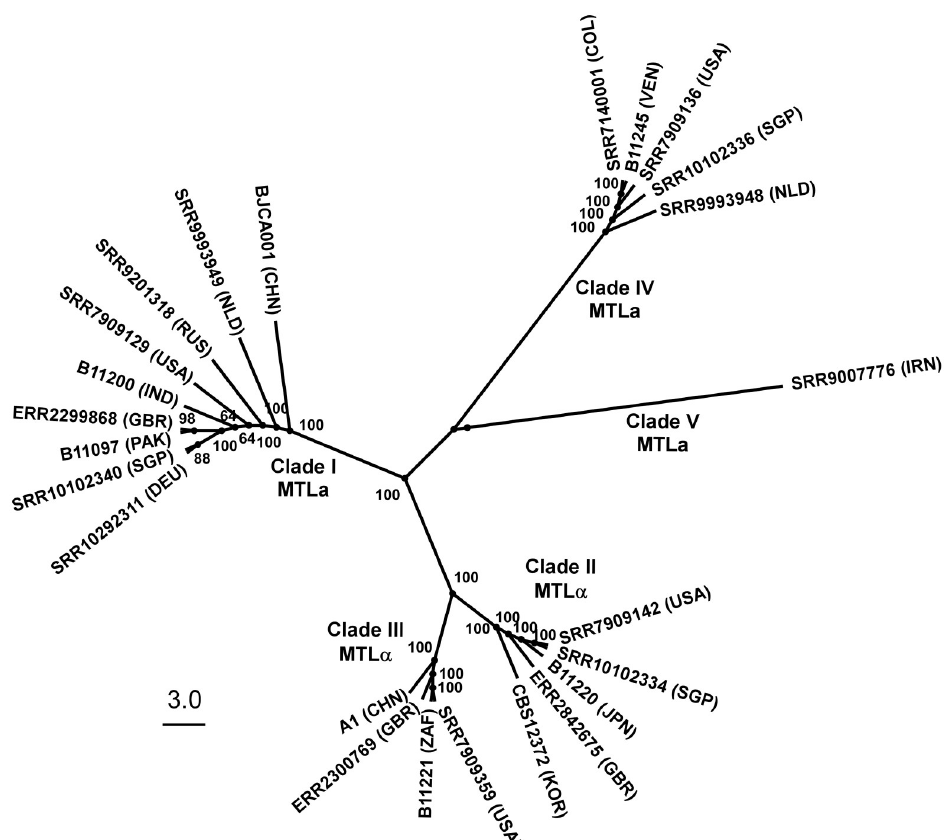
Fig 4. Five clades of C . auris . The phylogenic tree was generated with the program RAxML v7.3.2 using SNPs. The GTR model, gamma distribution, and 1,000 bootstraps were used to construct the phylogenetic relationships. The MTL are also included for each clade. CHN, China; COL, Colombia; DEU, Germany; GBR, United Kingdom; GTR, generalized time reversible; IND, India; IRN, Iran; JPN, Japan; KOR, Korea (South); MTL, mating type loci; NLD, the Netherlands; PAK, Pakistan; RUS, Russia; SGP, Singapore; SNPs, single-nucleotide polymorphisms; USA, United States of America; VEN, Venezuela describe the country where the strain was first isolated; ZAF, South